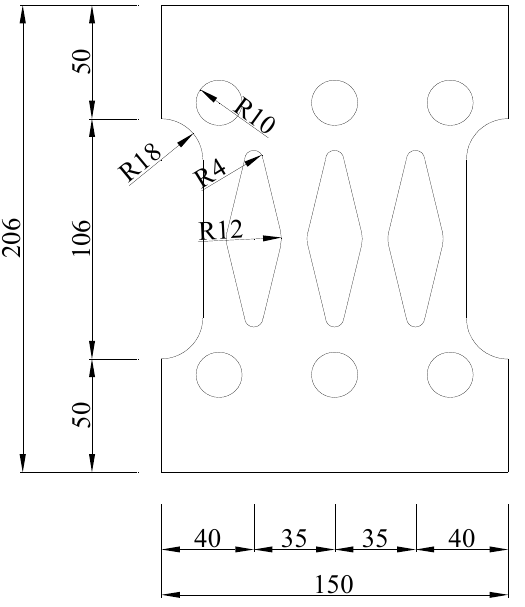
Figure 2. Diagram of EREDL (unit: mm).